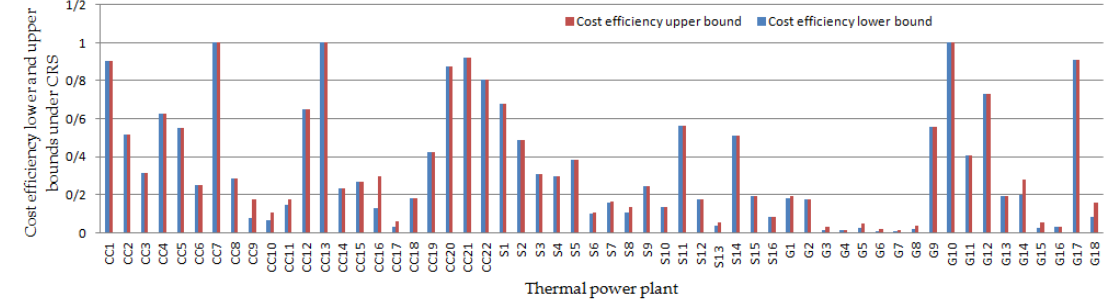
Figure 2. Comparisons of cost efficiency lower and upper bounds of 56 thermal power plants under CRS with the semi-disposability assumption.